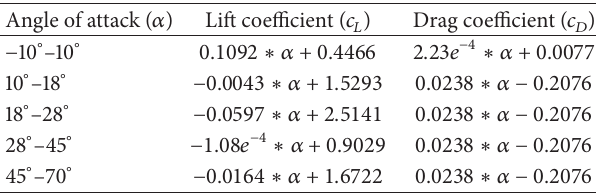
Figure 2: The blade profiles for the operation range of the wind turbine system. For the whole wind speed range, refer to [4]. Table 1: Linearized lift and drag coefficient expressions for different angle of attack regions.